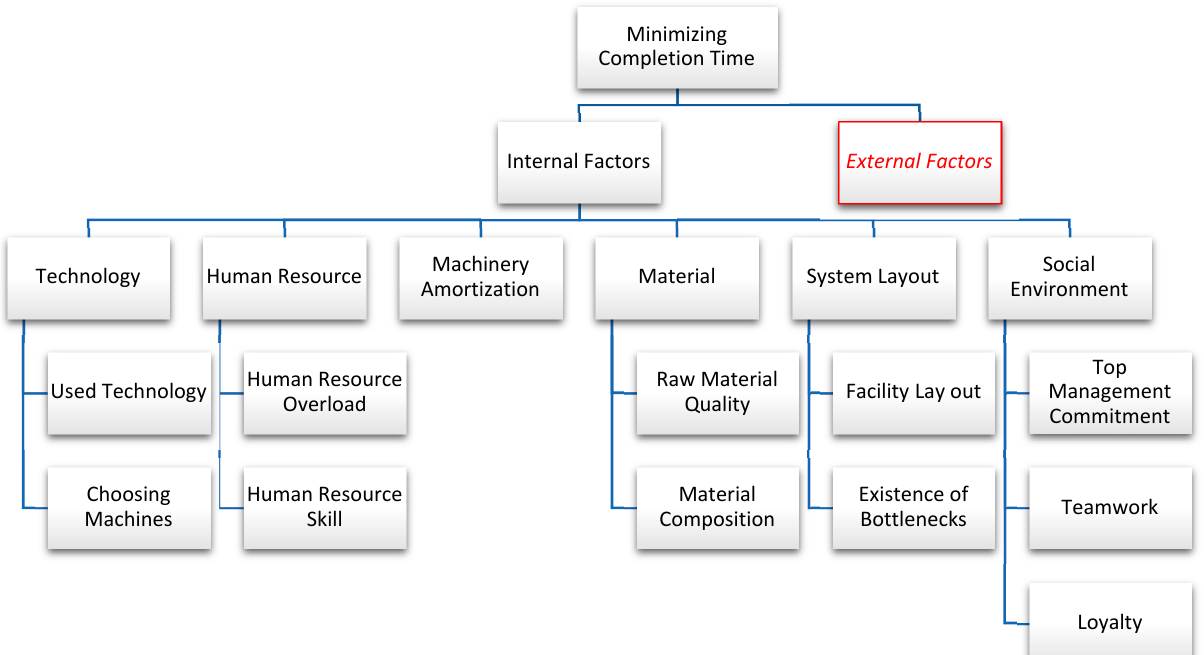
Figure 4. Factors that can influence processing time in a manufacturing firm.